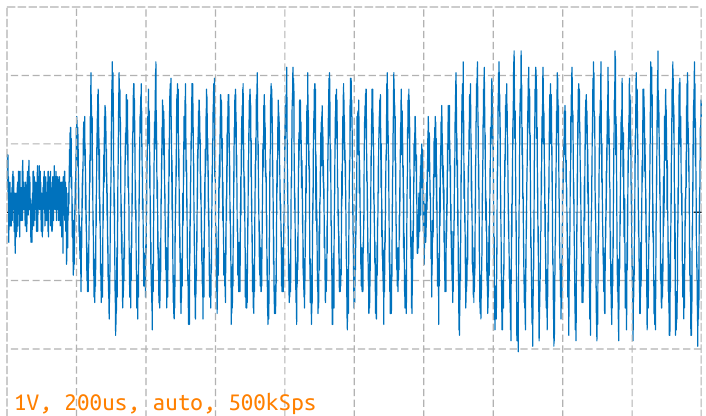
Figure 6. Received BPSK signal registered at the output of the amplifier. Signal registered with the Tectronics oscilloscope sampling at 500 kHz.